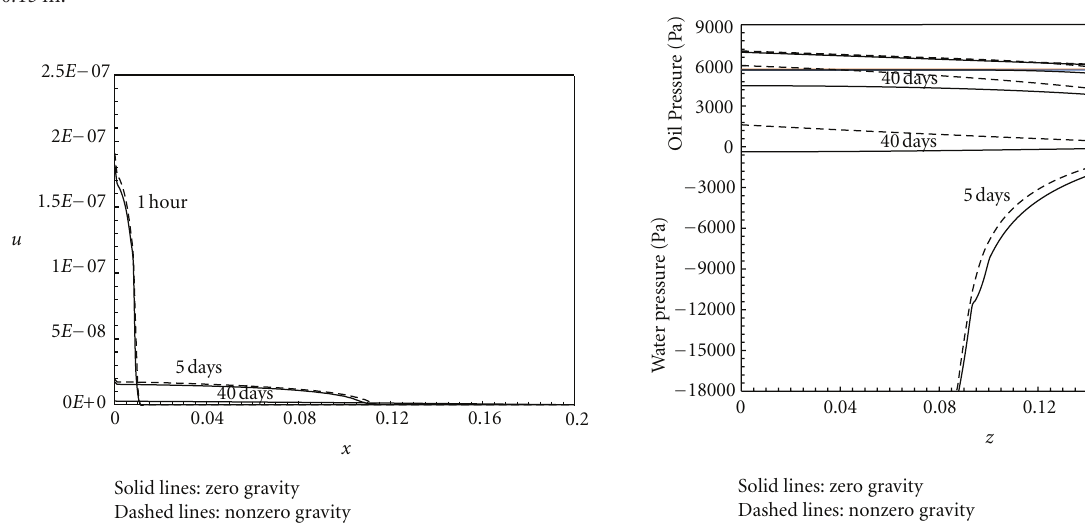
Solid lines: zero gravity Dashed lines: nonzero gravity Figure 5: Comparison between considering and neglecting gravity e ff ect on water and oil pressure against x -axis of Case A, at z = 0 . 15m.